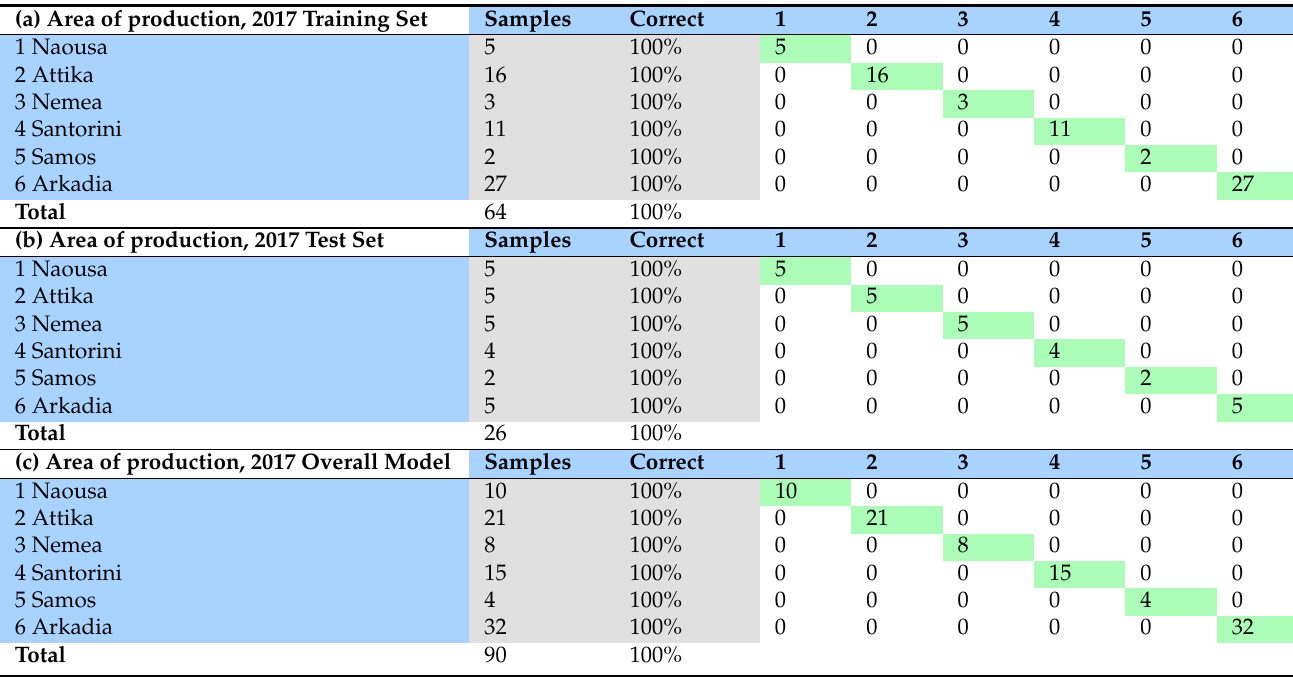
Table 8. Misclassification tables produced for the O2PLS-DA models of the wine samples of 2017 classified regarding area of production, where ( a ) training set, ( b ) test set, ( c ) overall model.